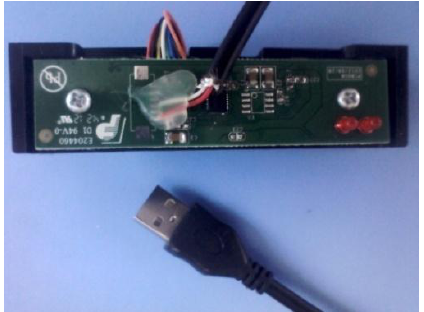
Figure 12. Photo of magnetic card swiping system with USB’s interface.